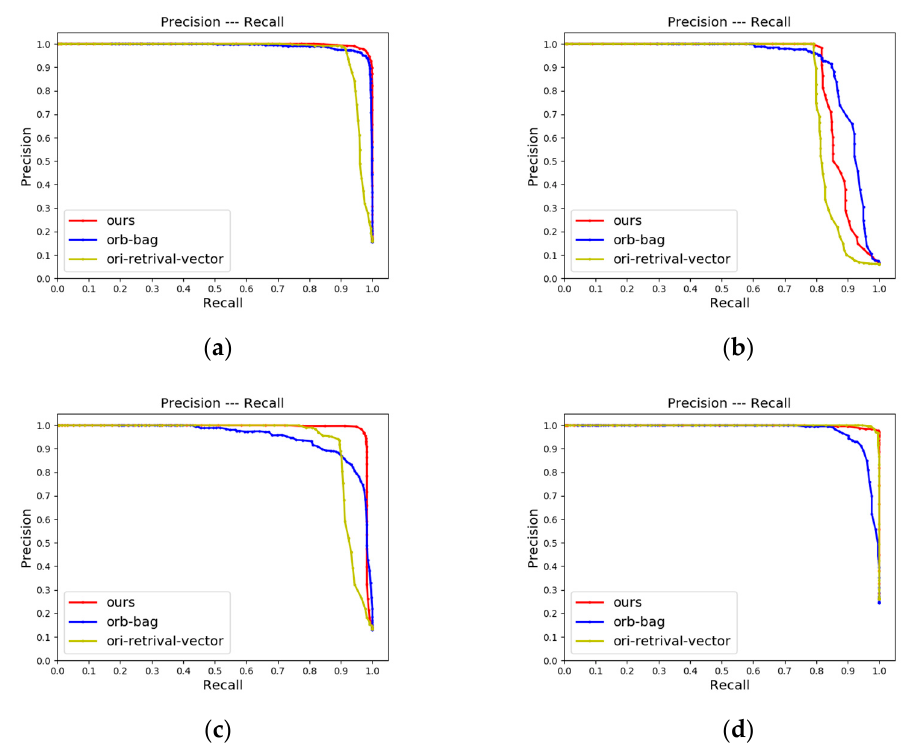
Figure 13. P-R curves of CMCD, orb-bag, and ori-retrieval-vector on KITTI odometry sequences: ( a ) The P-R curve of KITTI-00; ( b ) The P-R curve of KITTI-02; ( c ) The P-R curve of KITTI-05; ( d ) The P-R curve of KITTI-06.